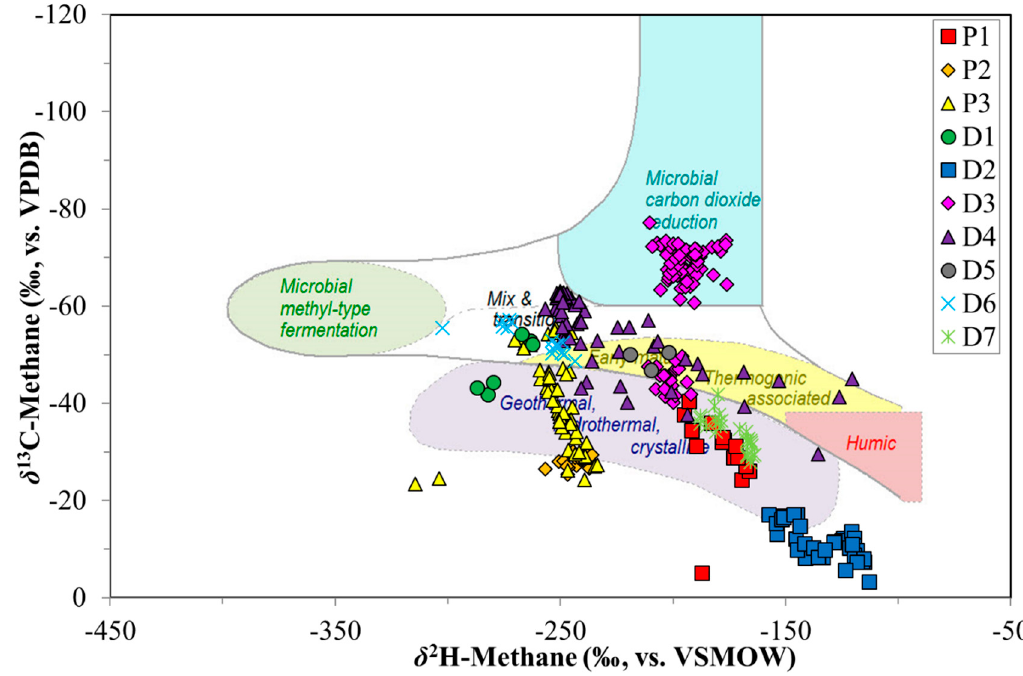
Figure 5. Cross-plot of methane δ 2 H and δ 13 C ratios. Based on the methane isotope composition, potentially different origins can be determined and are shown in the diagram with distinct areas. Data points indicate example wells or canisters for the different sample sets. See text for details. Modified from Whiticar [31].